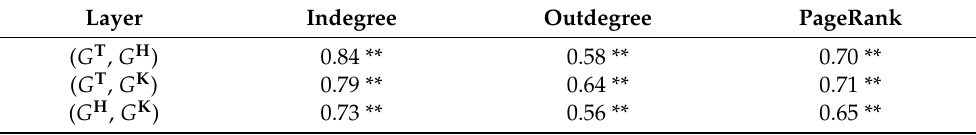
Table 4. Spearman’s rank correlation between layers for indegree, outdegree, and PageRank. Layer Indegree Outdegree PageRank